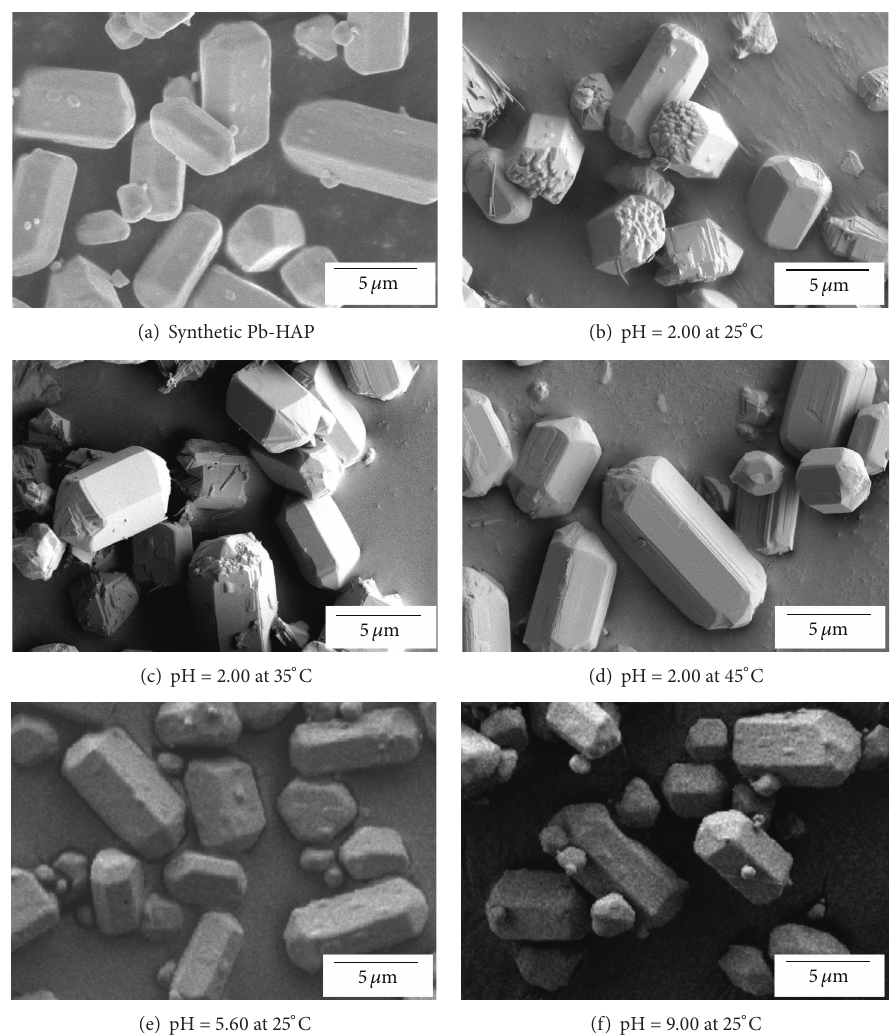
Figure 3: Field emission-scanning electron microscopy (FE-SEM) images of the synthetic lead hydroxypyromorphite [Pb 5 (PO 4 ) 3 OH] before (a) and after (b–f) dissolution at 25–45 ∘ C for 300